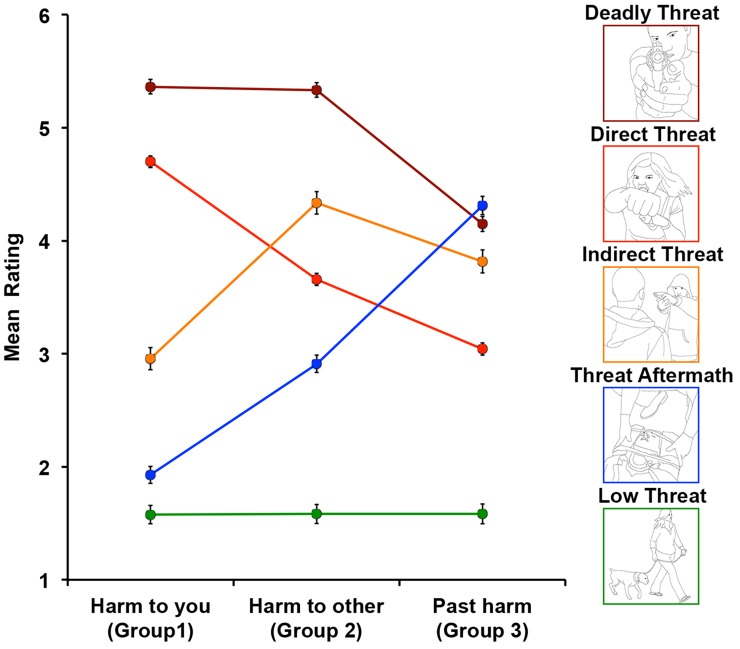
Five distinct image categories with corresponding prototypical examples.